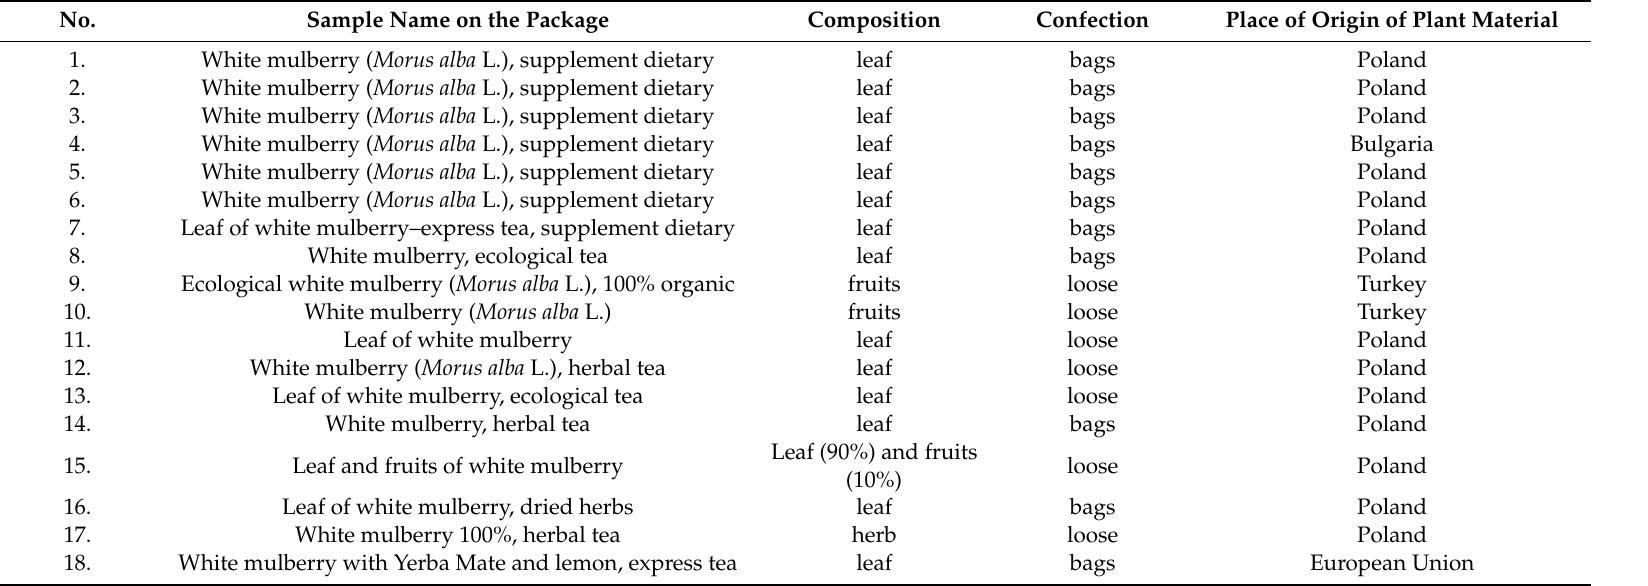
Table 5. List of analyzed commercial samples of Morus alba